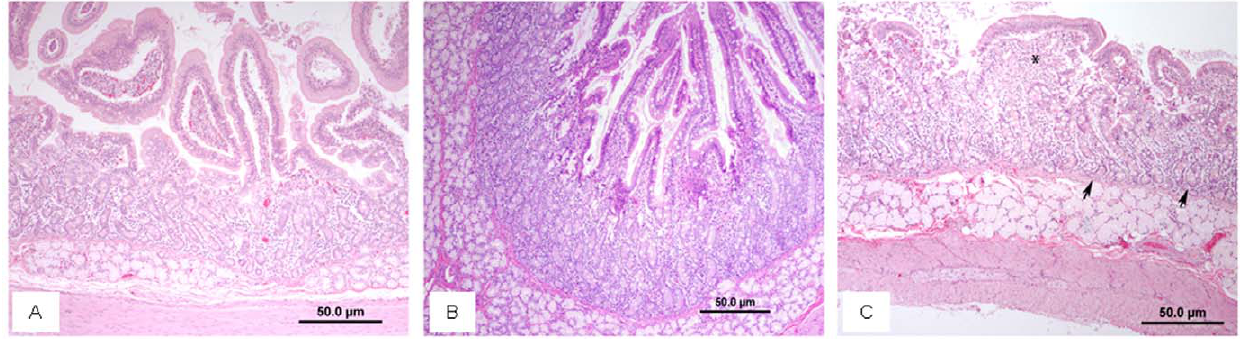
Figure 3. Histological examination of crypts and villi in the duodenum of irradiated minipigs (1.6 to 2.0 Gy). Samples were collected and fixed at necropsy. Panel A (1.6 Gy, H&E 100 6 ). Villar length is consistent throughout the section, and is of normal length, lined by a single layer of columnar epithelium with basilar nuclei and abundant eosinophilic apical cytoplasm. Underlying crypts are densely packed. Panel B (1.9 Gy, H&E 100 6 ). Villar length remains consisted in length and in morphology of the overlying epithelium as well as the abundance and morphology of the underlying villar crypts. Panel C (2.0 Gy, H&E 200 6 ). Multifocally throughout the section, villi are blunted and fused (asterix) with multiple villi recovering by denudation by being covered by a single layer of columnar epithelium. Underlying crypts (arrows) have piled epithelium and occasionally are tortuous; however there is no apparent loss of crypts.